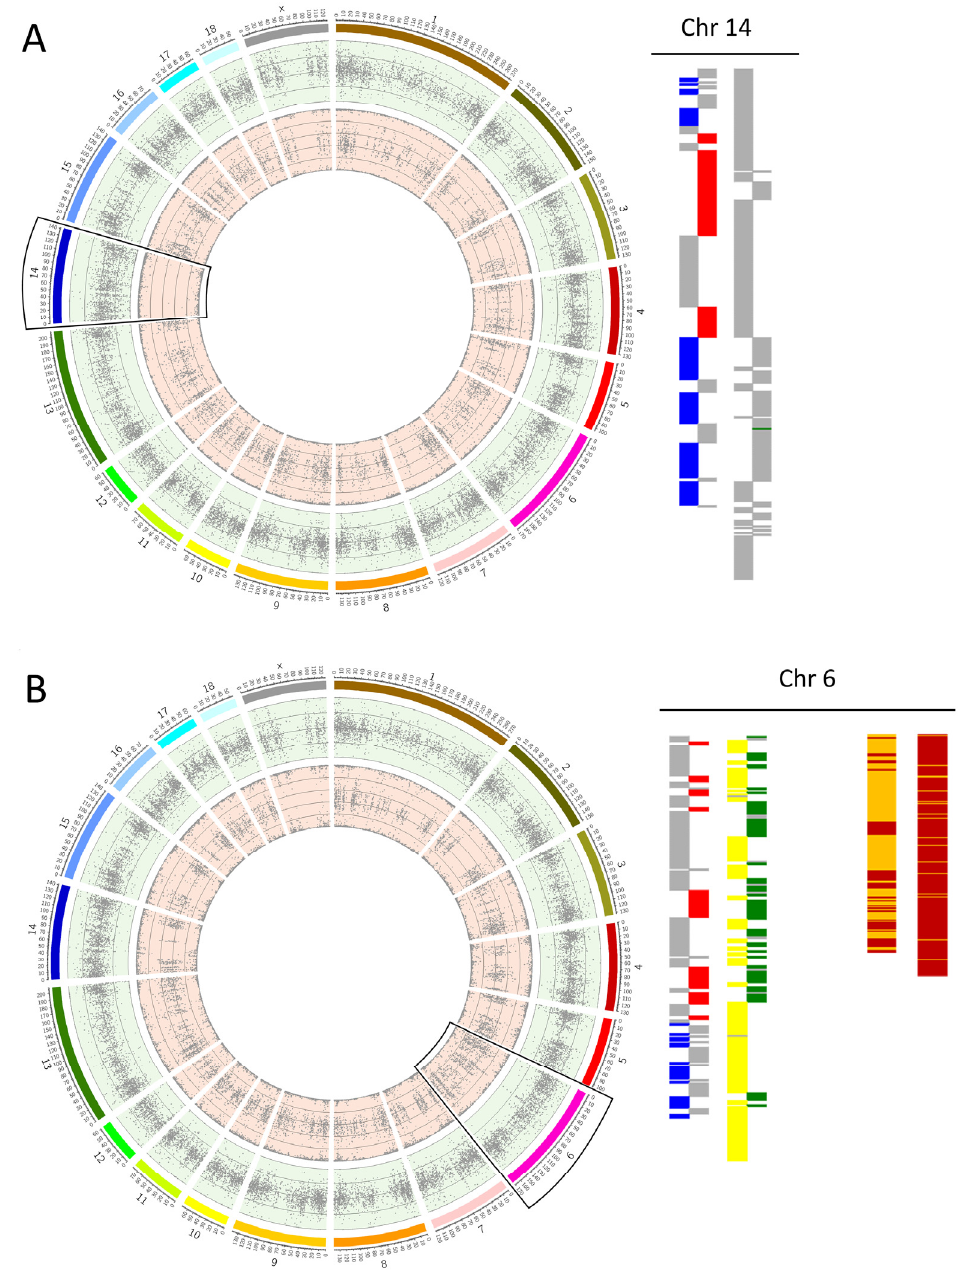
Figure 1. Examples of aneuploidy cases in porcine embryos. ( A ) In vivo embryo with a maternal monosomy on chromosome 14. In the circle graph with BAF and LRR plots, the monosomy is indicated by a lower LRR (green bond) and lack of heterozygosity, shown by missing dots at 0.5 on the BAF (light red bond). The figure on the right shows how the maternal monosomy is demonstrated on the Karyomapping by the presence of haploblocks in the paternal block (blue/red) and the absence of these in the maternal block (where it should be yellow/green, there is only grey blocks—missing of information); ( B ) In vivo embryo identified as having a maternal trisomy on chromosome 6 shown by an increased LRR value and with two inner bonds in the BAF plot (AAB, ABB). On the Karyomapping, the maternal block shows a higher change of haploblocks through the chromosome, which demonstrates the extra information in this chromosome. For trisomies an additional algorithm was applied, the Gabriel–Griffin plot, which in this case showed that this trisomy arose during the Meiosis I.